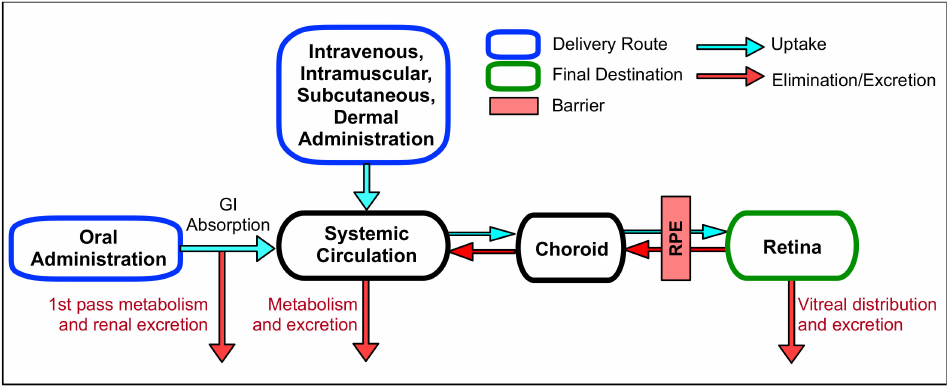
Figure 2. Systemic drug delivery to the retina via oral, intravenous, intramuscular, subcutaneous, and dermal administration. The drugs administered via these routes need to be intact against metabolism and excretion in gastrointestinal (GI) tract and systemic